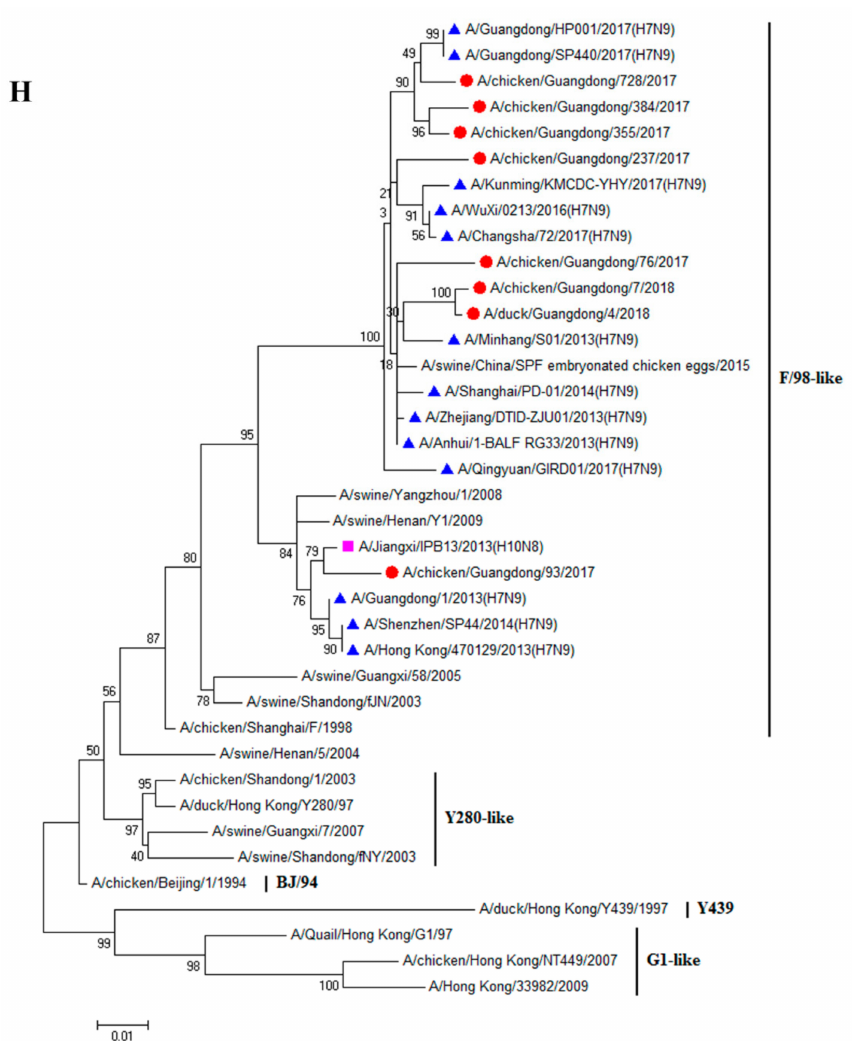
Figure 1. Phylogenetic analysis of eight H9N2 influenza viruses. ( A ) Phylogenetic trees of HA genes based on nucleotides (nt) 34 to 1716. ( B ) Phylogenetic trees of NA genes based on nt 20 to 1420. ( C ) Phylogenetic trees of PB2 genes based on nt 28 to 2307. ( D ) Phylogenetic trees of PB1 genes based on nt 25 to 2298. ( E ) Phylogenetic trees of PA genes based on nt 25 to 2175. ( F ) Phylogenetic trees of NP genes based on nt 46 to 1542. ( G ) Phylogenetic trees of M genes based on nt 26 to 1007. ( H ) Phylogenetic trees of NS genes based on nt 27 to 864. Solid red circles indicate H9N2 avian influenza viruses isolated in this study, solid blue triangles indicate H7N9 viruses, and solid pink squares indicate H10N8 viruses. The sequences were aligned by the Clustal W and Maximum Likelihood method (ML), trees were generated with 1000 bootstrap replicates using MEGA